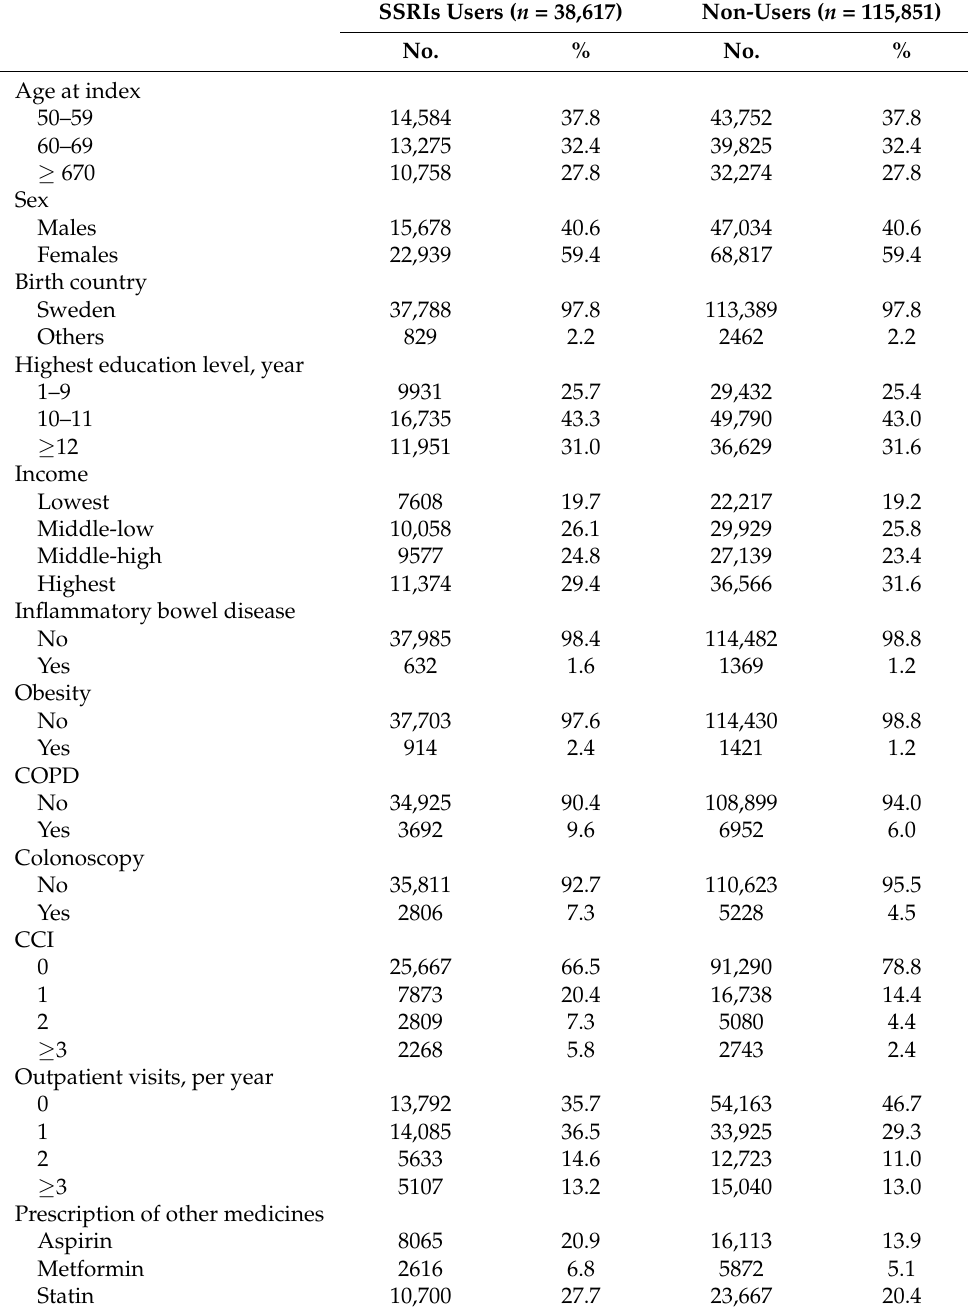
Table 1. Demographic and clinical characteristics among SSRIs users and matched controls in people with a family history of